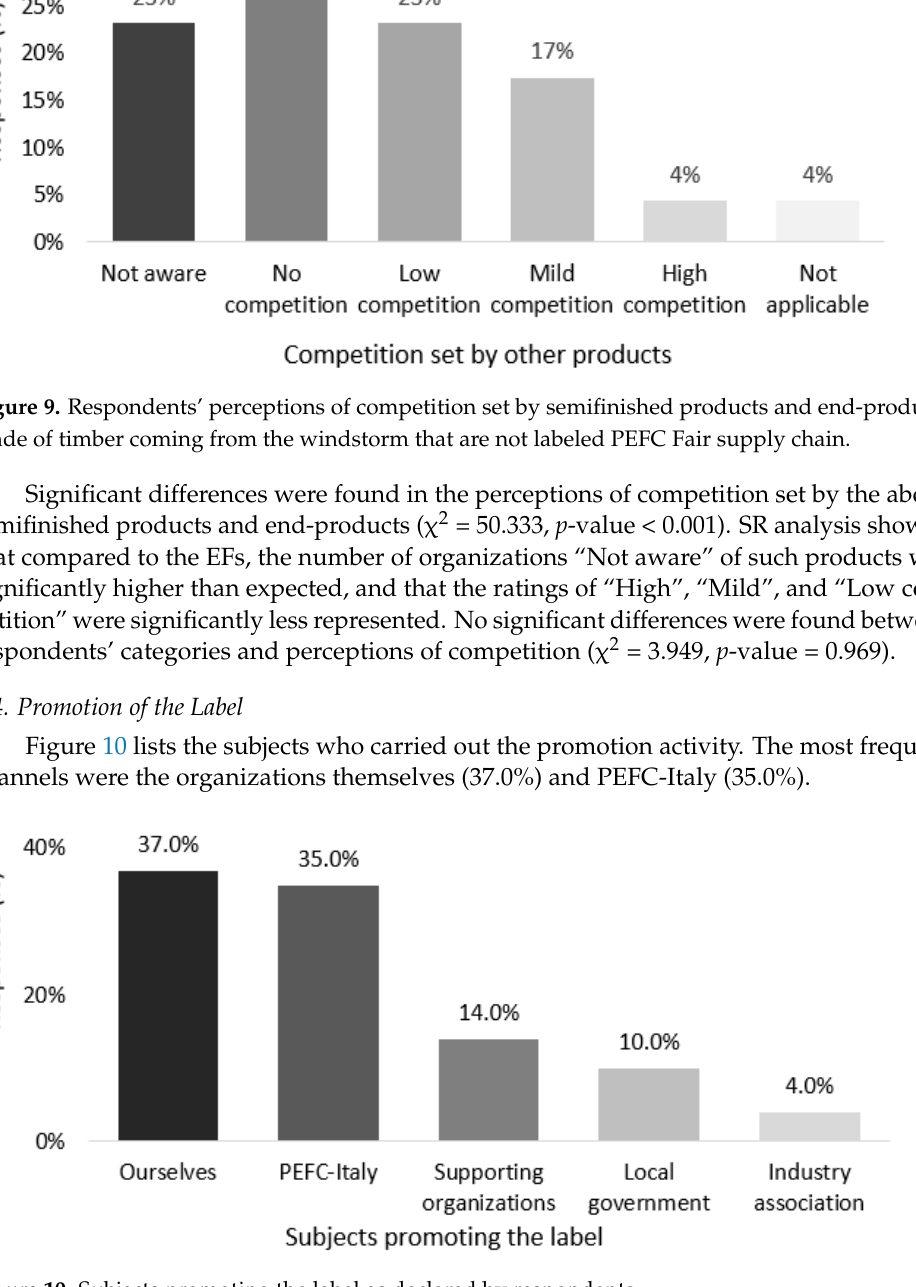
Figure 11. Methods used by respondents to promote the initiative.